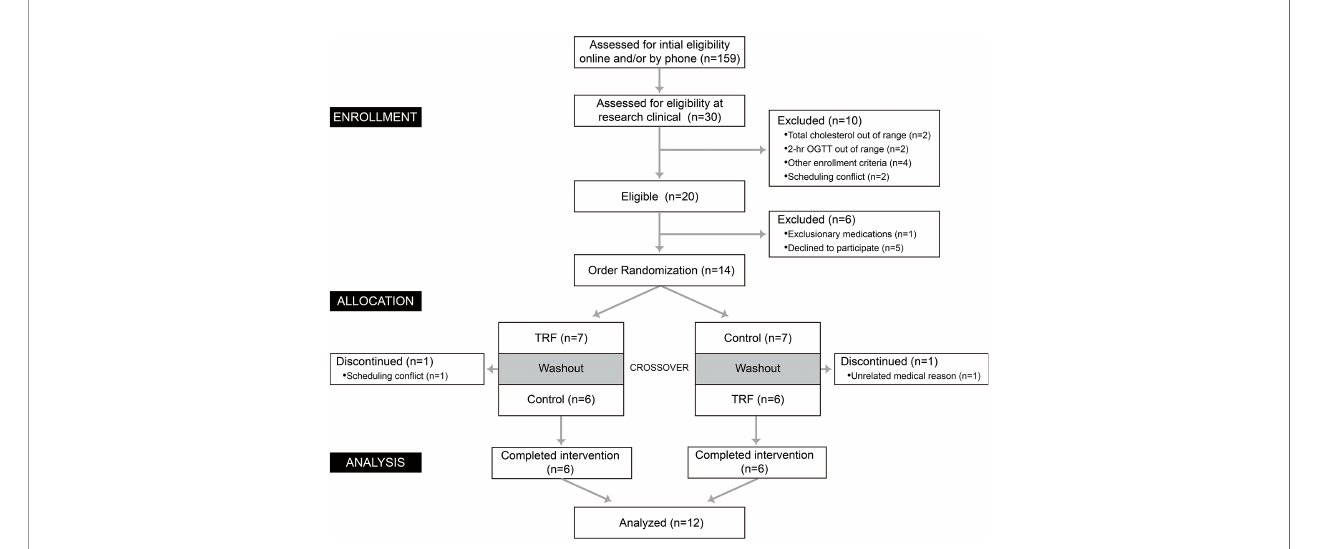
FIGURE 1 | CONSORT fl ow diagram indicating the design of the